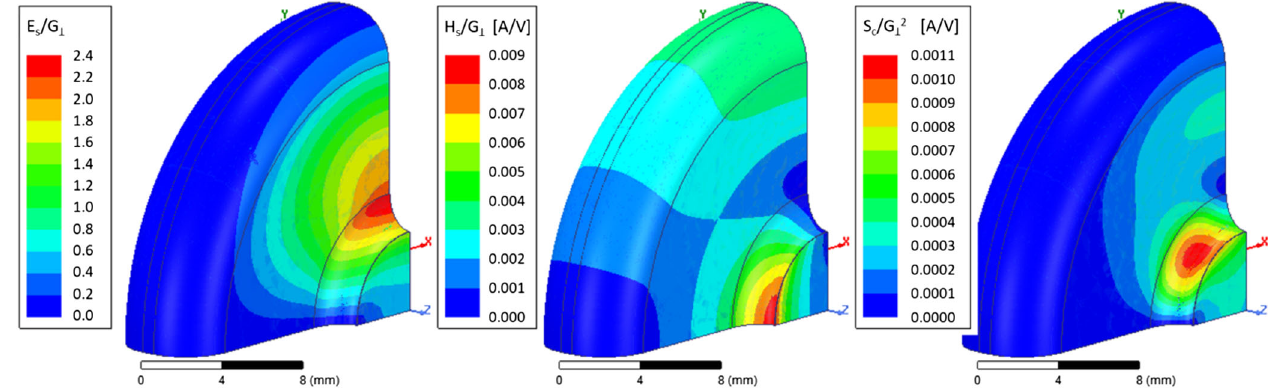
FIG. 9. Distributions of the normalized electric (left) and magnetic (middle) fields and of the normalized modified Poynting vector (right) on the cell